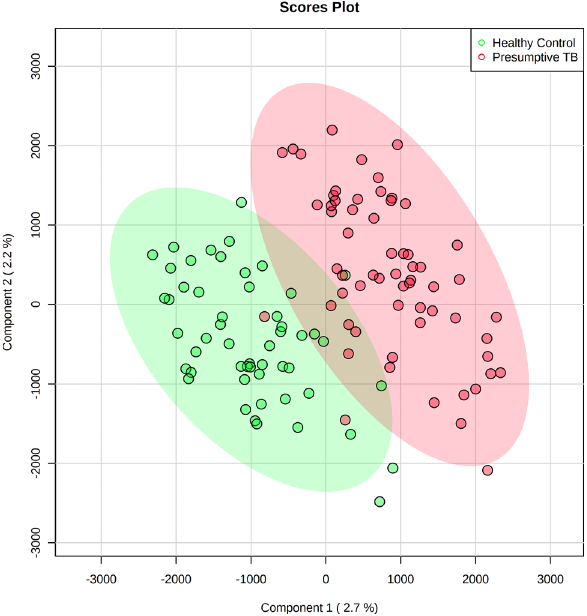
Figure 2. Partial least squares discriminant analysis (PLS-DA) score plot of urine spectra measured using high-field proton (1H) nuclear magnetic resonance spectroscopy of children with presumptive TB (n = 61) and healthy children (n = 54). Two-dimensional view showing the distribution of the groups according to the first two components of the PLS-DA model. TB, tuberculosis. Metaboanalyst 5.0. (https:// www. metab oanal yst. ca).